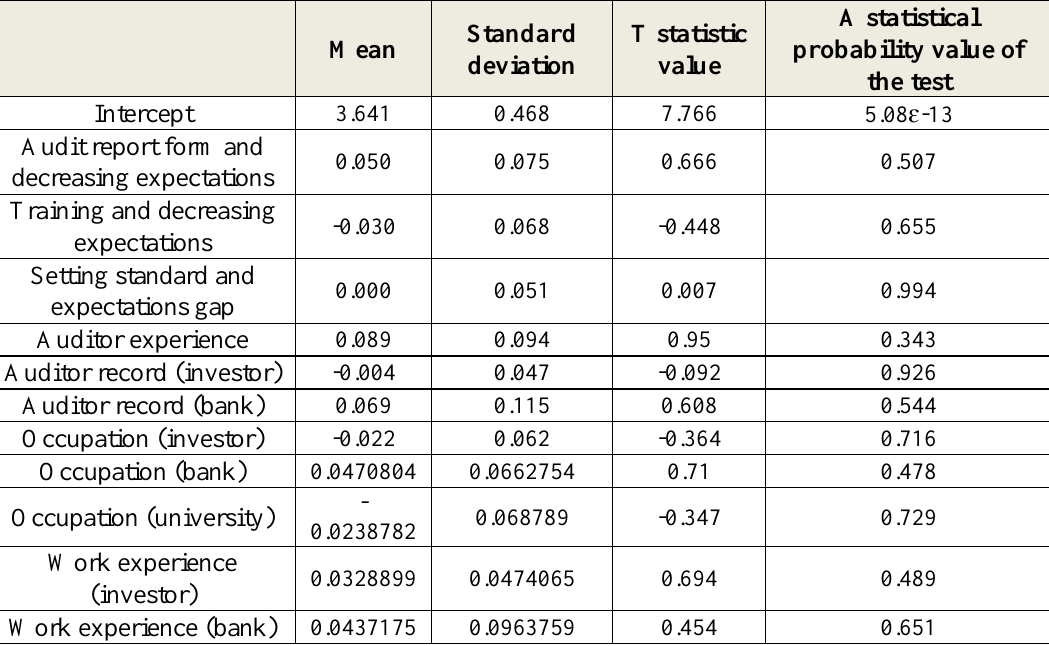
Table 5. Results of regression of the relationship between users of financial statements